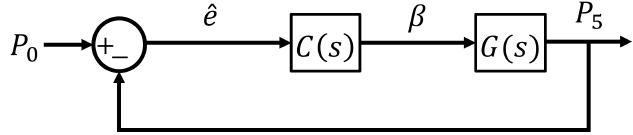
Figure 3. Nozzle control considering static pressure feedback.